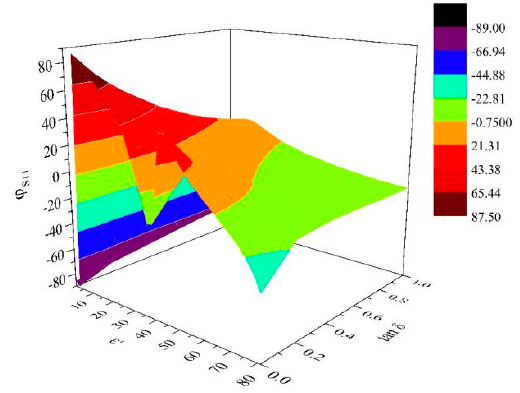
Figure 5. Relationship diagram of ϕ S